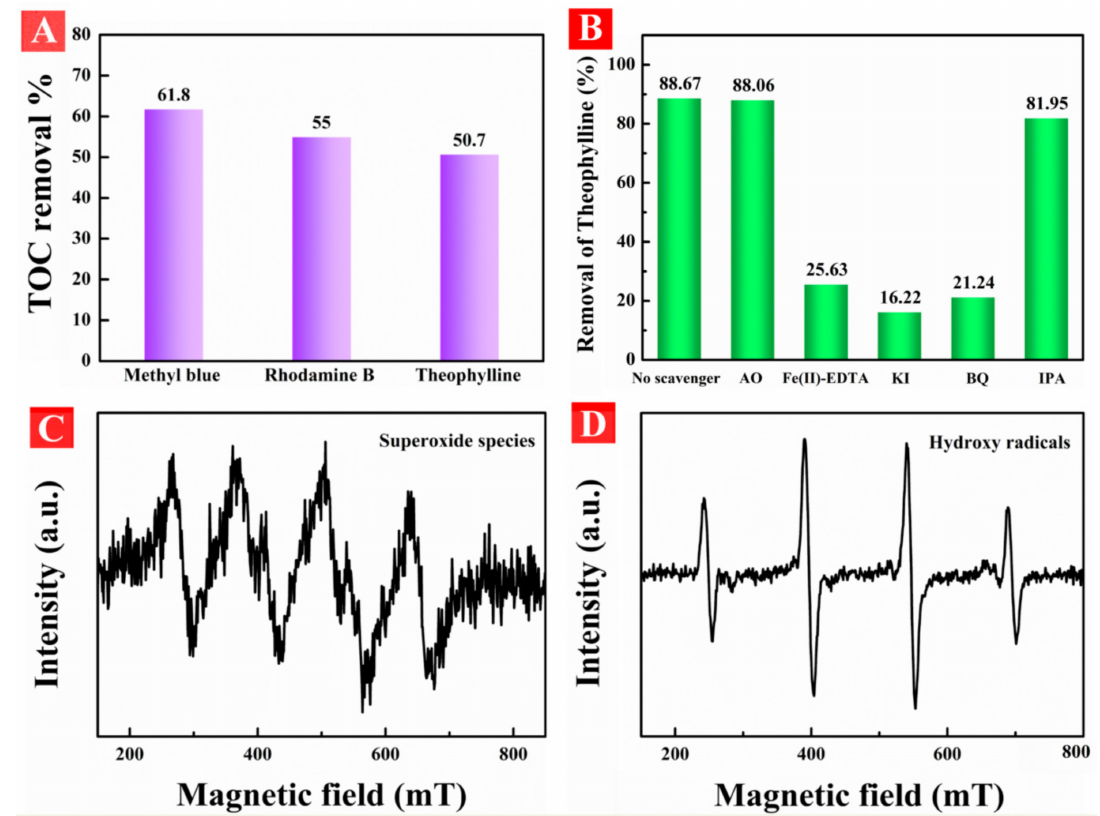
Figure 11. ( A ) The total organic carbon (TOC) tests for decomposed polluted water of RhB, MB, and theophylline. ( B ) reactive oxidant scavenging experiments. ( C , D ) were the electron paramagnetic resonance (EPR) detection of O 2 − and OH, respectively, in aqueous solutions with visible light irradiation.